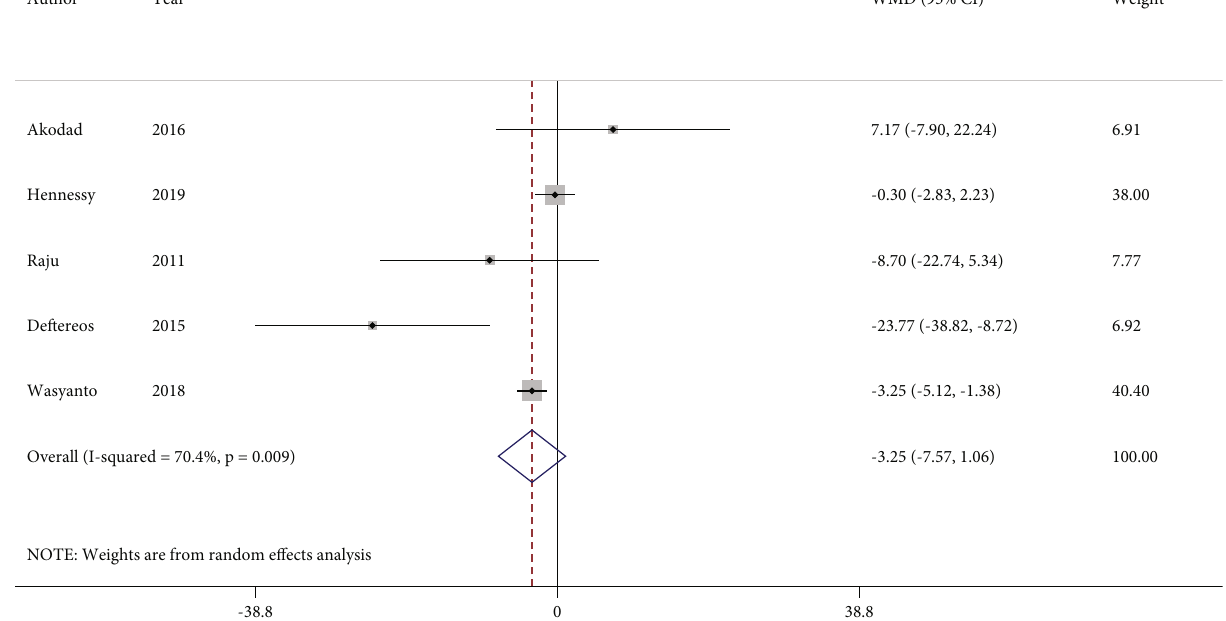
Figure 2: Forest plot displaying weighted mean di ff erence and 95% con fi dence intervals for the impact of colchicine on high-sensitivity C- reactive protein (hs-CRP) serum level in patients with acute coronary syndrome. WMD: weighted mean di ff erence; CI: con fi dence